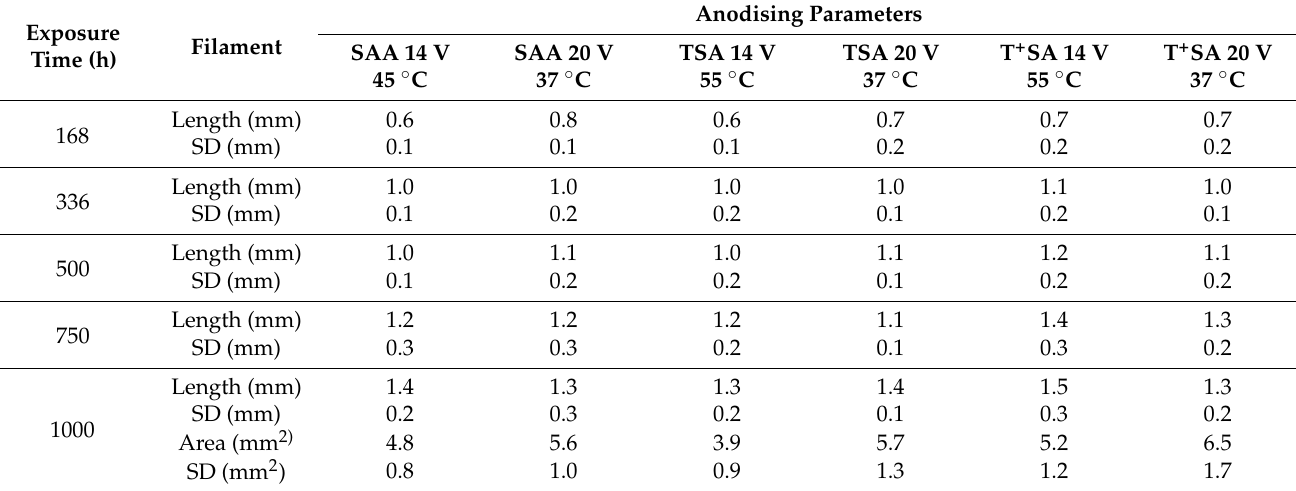
Table 4. Summary of filiform corrosion test results.